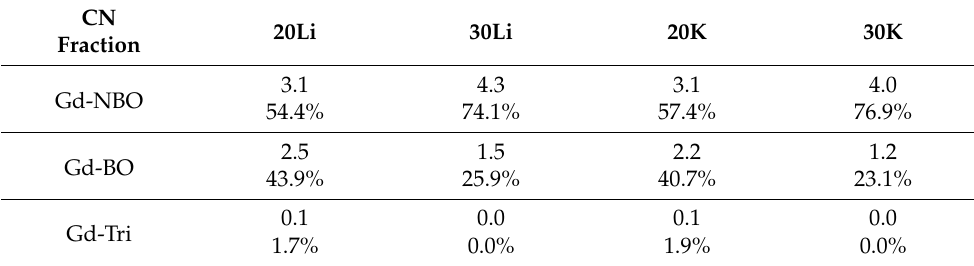
Table 8. Separation of Gd-O coordination numbers (CN) into non-bridging oxygen (NBO), bridging oxygen (BO), and tri-cluster oxygen ions (Tri) and their